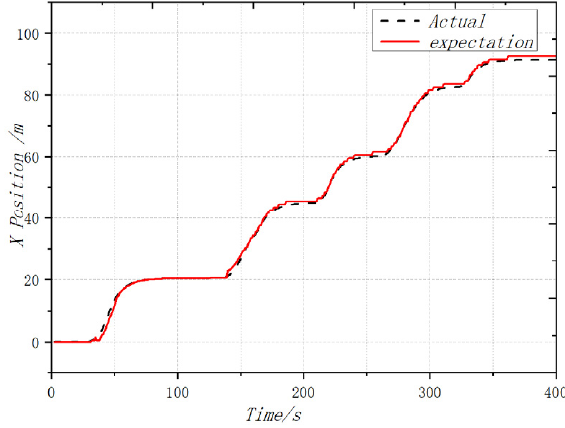
Figure 11. Expected value and actual value of dynamic flight X direction.